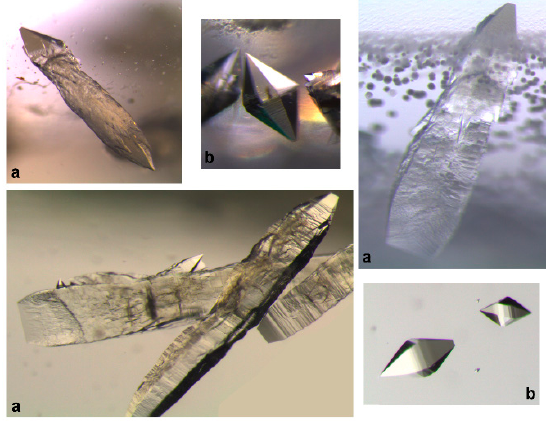
Figure 4. ( a ) Crystals of 3D- dia grown at the solution-gel interface. The bottom part of the crystals, grown in gel, appeared clearly warped with an elongated shape. ( b ) Crystals of 3D- dia grown in solution with a well-defined bipyramidal